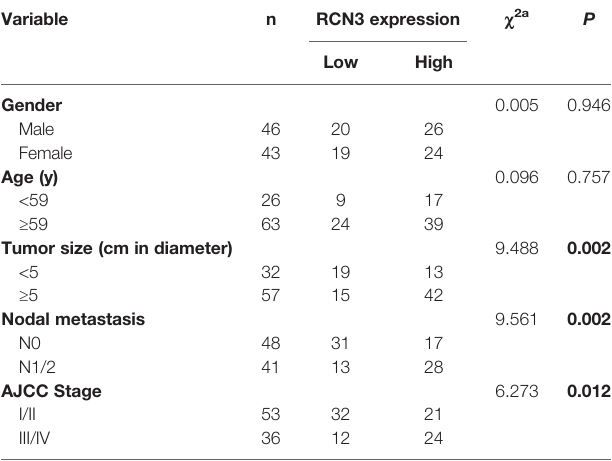
large fraction of cancers, including COAD, READ, MESO, LIHC, LGG, and KIRC ( Figure 6 ). KEGG GSEA analysis demonstrated that RCN3 was mainly involved in “ ECM − receptor interaction ” , “ cytokine-cytokine receptor interaction ” , “ focal adhesion ” , “ PI3K − Akt signaling pathway ” , “ chemokine signaling pathway ” , “ pathways in cancer ” , and “ Th1 and Th2 cell differentiation ” in COAD, READ, MESO, LIHC, LGG, and KIRC ( Supplementary Figure 6 ).